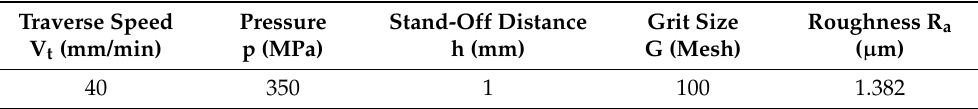
Table 8. Roughness values obtained consequently to machining with the work parameters adjusted to the optimum recommended